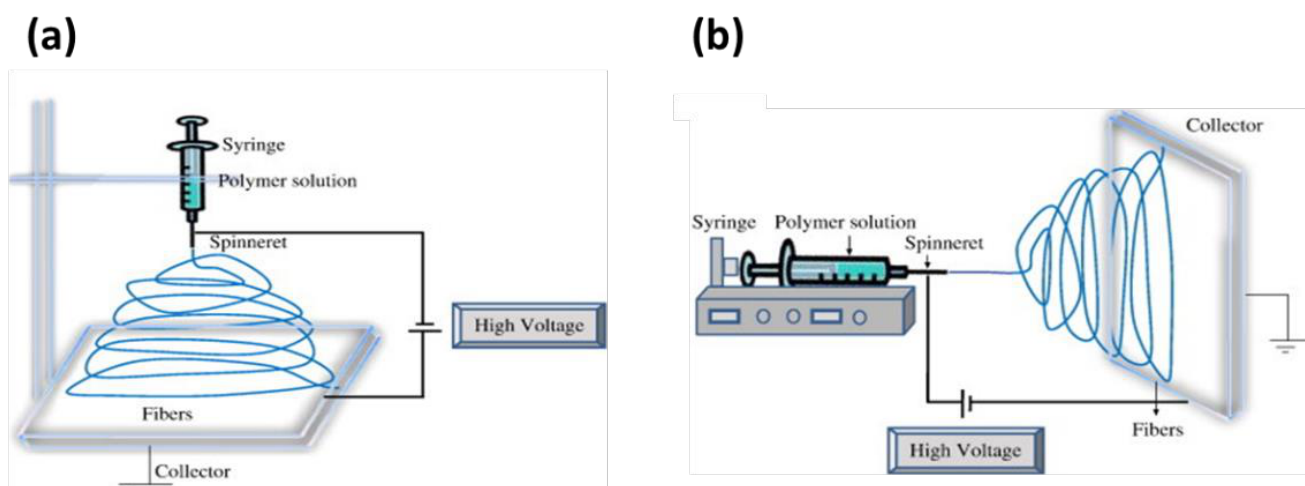
Figure 5. Schematic illustration of setting up of electrospinning apparatus: ( a ) typical vertical setup and ( b ) horizontal setup of electrospinning apparatus. Reproduced with permission from [53], copyright 2010 Elsevier.